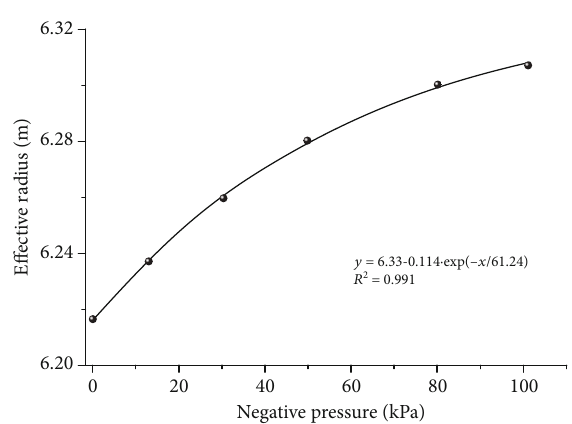
Figure 14: Correlation between negative pressure and e ff ective